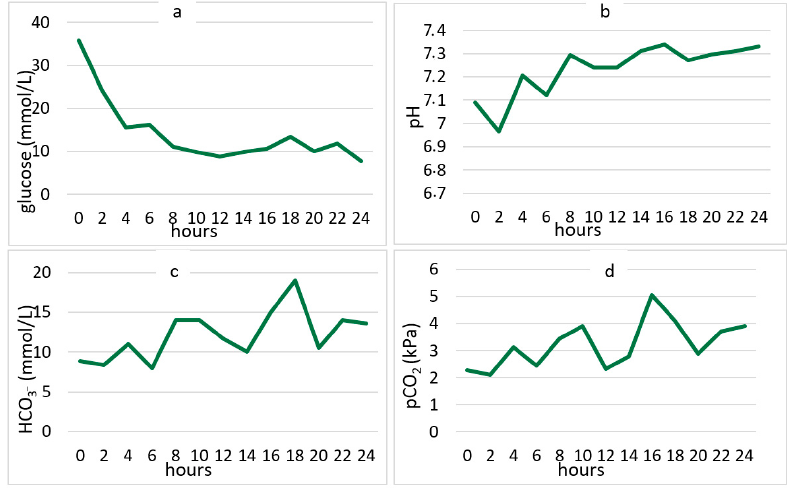
Figure 4. Average changes in blood glucose concentration ( a ), pH values ( b ), bicarbonate concentrations ( c ), and carbon dioxide partial pressure ( d ), for the children with